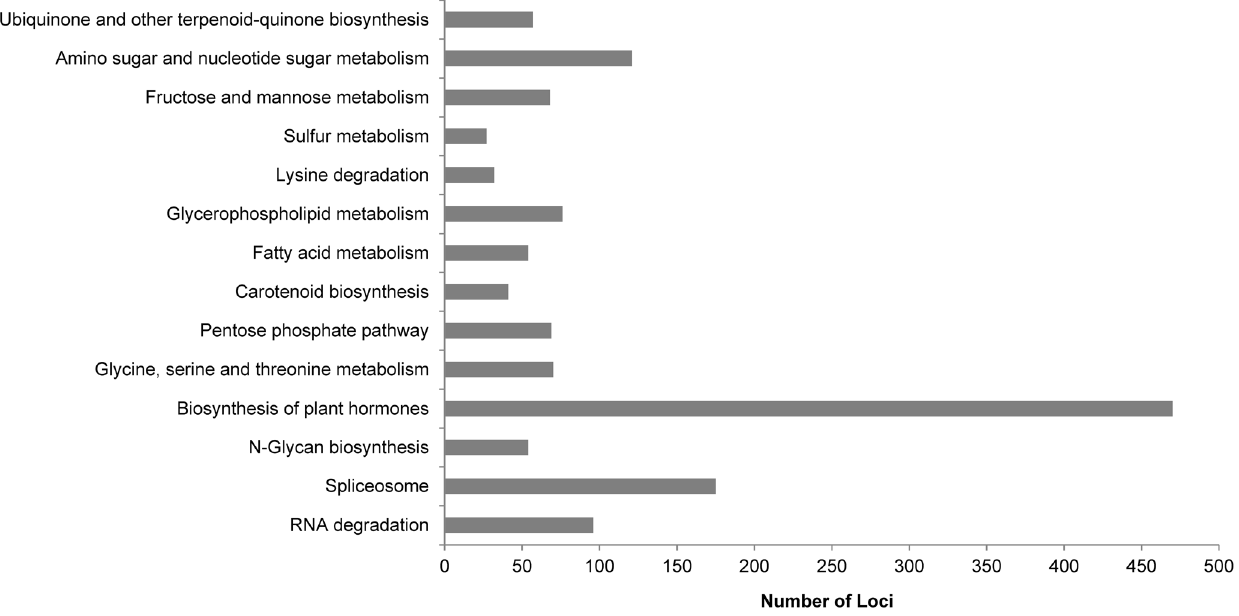
Figure 4. KEGG annotation of the cabbage assembly. KEGG annotation was performed using 18,761 TAIR IDs; 733 of the TAIR IDs covered 14 KEGG pathways. The 1,410 cabbage loci annotated by those TAIR IDs were sorted to the corresponding KEGG